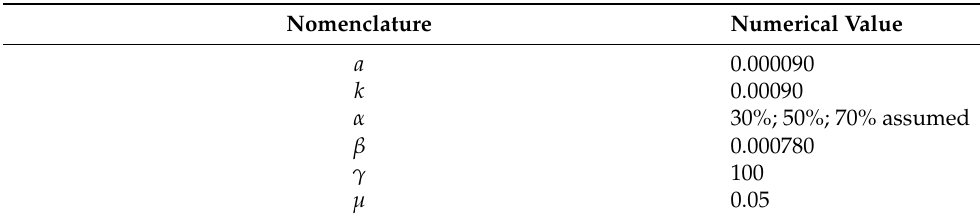
Table 2. Nomenclature and numerical values are taken from [7].